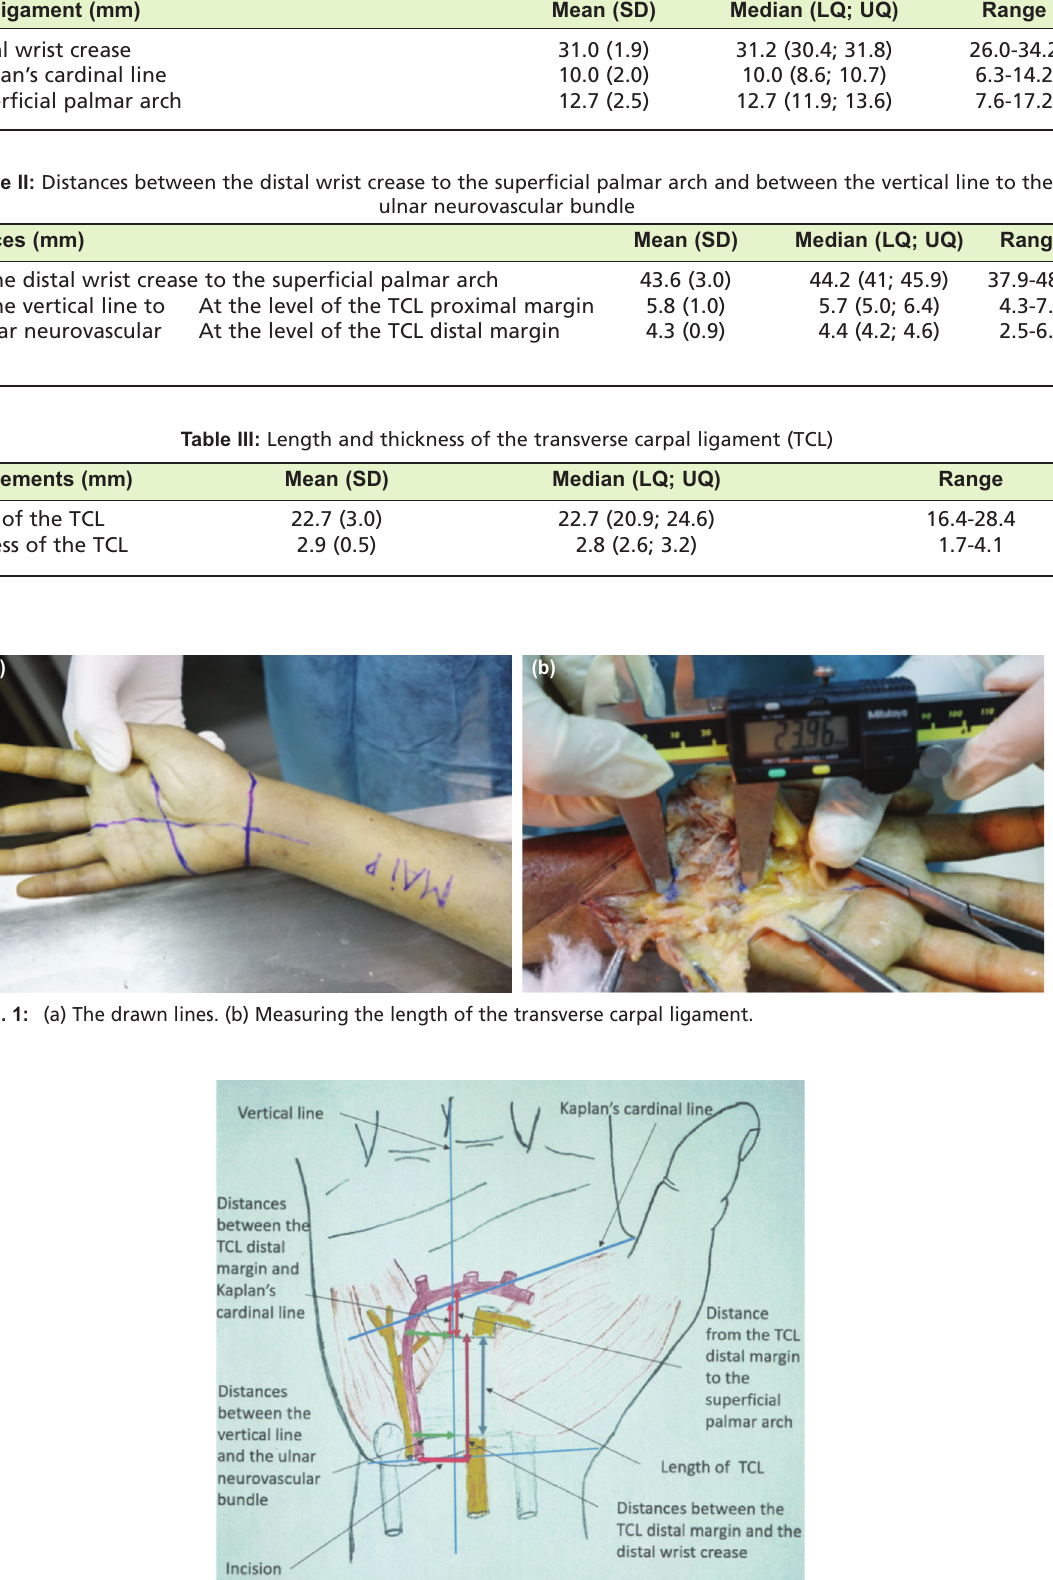
Distance from distal margin of the transverse carpal ligament to the drawn lines Table I: Distance from the distal margin of the transverse